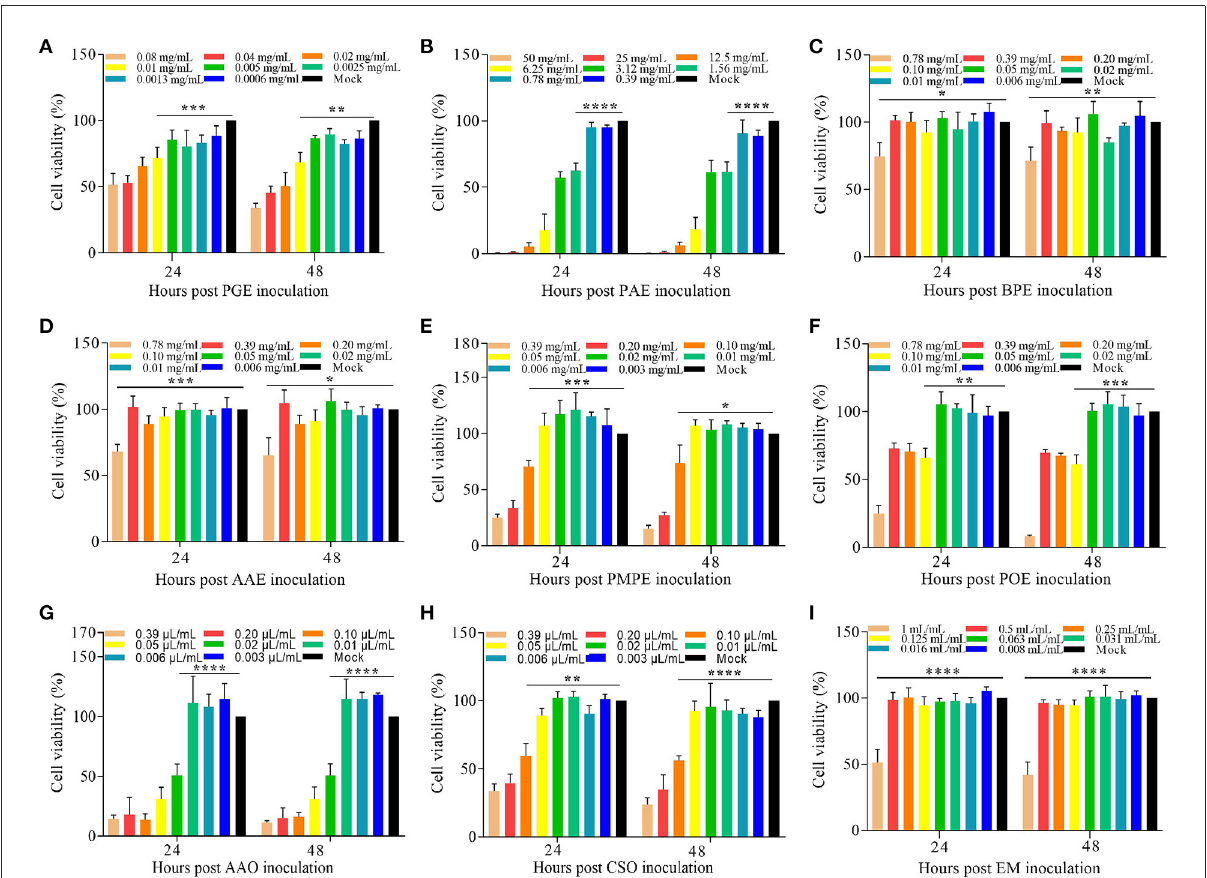
FIGURE2 Cytotoxicity of the eight plant extracts and essential oils and the EM in DF-1 cells in vitro . Viability (%) of DF-1 cells cultured with various concentrations of (A) PGE, (B) PAE, (C) BPE, (D) AAE, (E) PMPE, (F) POE, (G) AAO, (H) CSO, and (I) the EM relative to the Mock 24 and 48h before the CCK-8 assay. Data are expressed as means ± S.D. of three independent experiments. * P < 0.05, ** P < 0.01, *** P < 0.005, **** P < 0.001. AAE, Acalypha australis L. extract; AAO, Artemisia argyi Levl. et Vant. essential oil; BPE, Bidens pilosa L. extract; CCK-8, Cell Counting Kit-8; CSO, Camellia sinensis (L.) O. Ktze essential oil; DF-1, chicken embryo fibroblast; EM, extract and essential oil mixture (non-toxic concentrations of PGE, PAE, BPE, AAE, PMPE, POE, AAO, and CSO); PAE, Plantago asiatica L. extract; PGE, Punica granatum L. extract; PMPE, Pteris multifida Poir extract; POE, Portulaca oleracea L. sp. Pl.